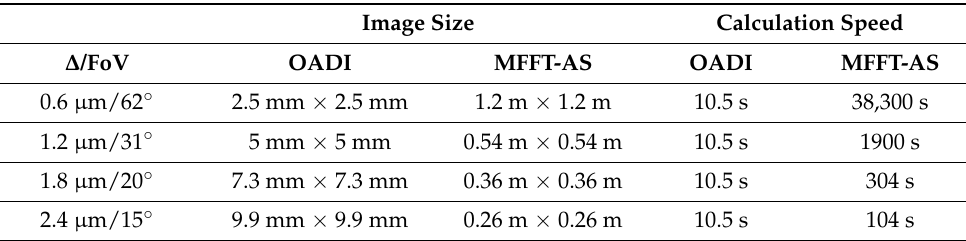
Table 1. Calculated Field of View and computation time for the off-axis direct integration method and the MFFT-AS, λ = 640 nm, z = 1000